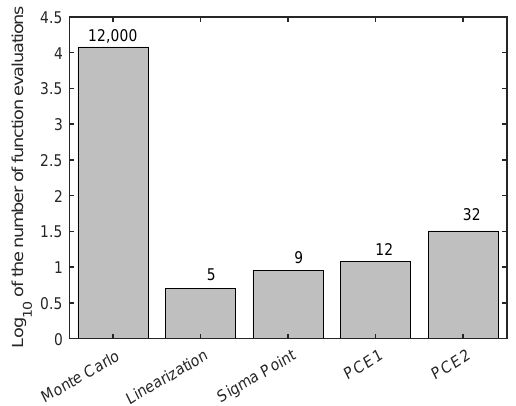
Figure 11. The number of samples or function evaluations required for each